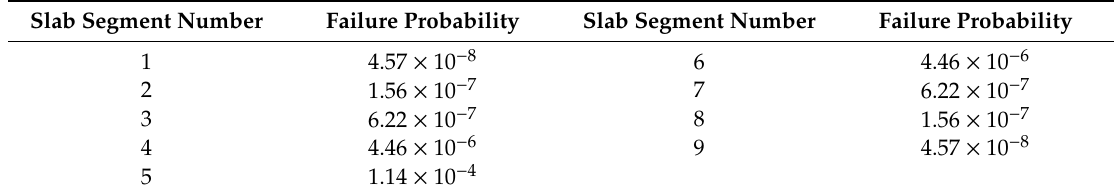
Table 4. The failure probability of each slab